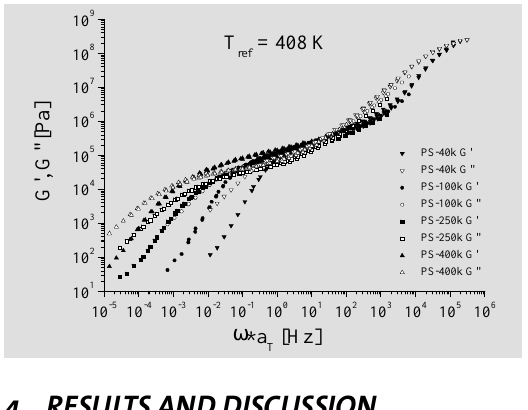
Figure 2: Master curves of G’ and G’’ for the different PS- samples referenced to T ref = 408 K. More than ten decades along the frequen- cy axis and nearly eight decades along the modulus axis are covered.